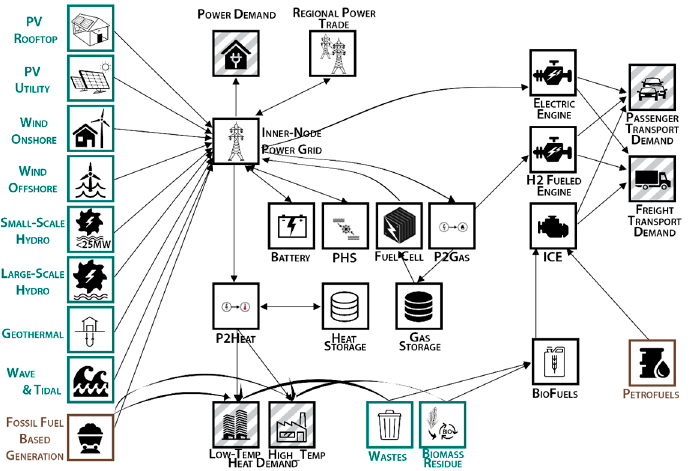
Figure 2 . Layout of GENeSYS-MOD. Figure 2. Layout of